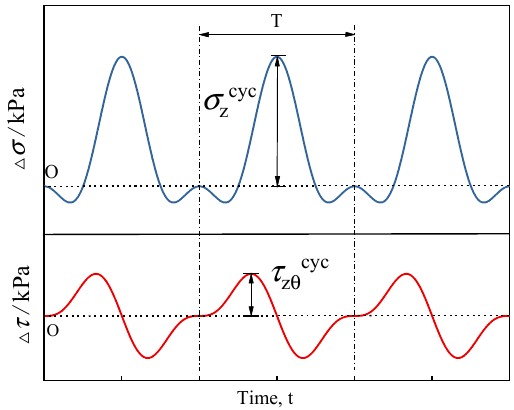
Figure 4. Diagram of loading waveforms.